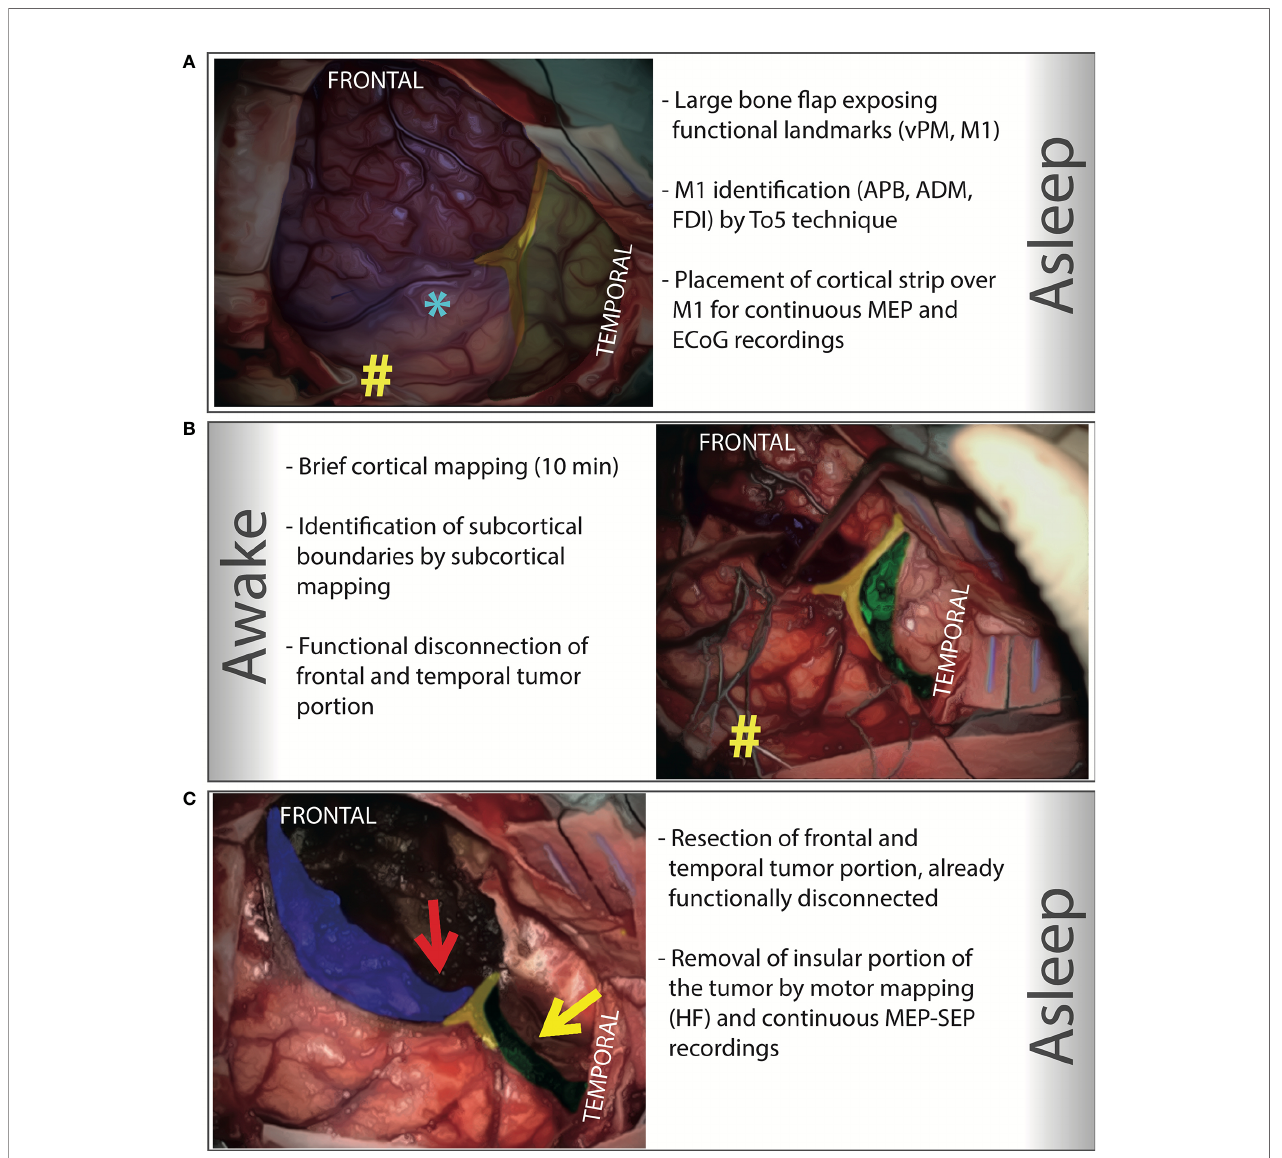
FIGURE 1 | Step-by-Step illustration of an asleep-awake-asleep transcortical approach to a right giant insular low-grade glioma. Intraoperative pictures have been colored with different inks to highlight the key elements of each step. (A) A large bone fl ap exposing the functional cortical landmark (M1 and vPM, marked with # and *, respectively) is designed and performed under general anesthesia. The motor cortex is identi fi ed (by HF stimulation, Train of Five, ISI 3, delivered by a monopolar probe), looking for hand muscle responses (APB, ADM, FDI) at cortical motor threshold (the lowest current intensity which produced the lowest MEP response); a cortical strip is placed over this area to obtain a continuous MEP monitoring; the same strip is also used to record ECoG. (in blue is colored the frontal lobe, in green the temporal lobe, and in yellow the Sylvian fi ssure). (B) The awake phase consists of a cortical and a subcortical step. In the cortical step, which last approximately 10 minutes, by cortical mapping (LF delivered by a bipolar probe) functional cortical sites are located over the frontal and the temporal lobe, and negative cortical sites identi fi ed to design the safe cortical entry zone in both frontal and the temporal lobe; the corticectomy is then performed at the posterior border of both lobes. In the subcortical step (20-30 minutes on average), with the aid of subcortical mapping, the functional limits in the frontal and temporal lobes are identi fi ed. Limits are immediately sought at the periphery, starting from the corticectomies. In this way, a functional disconnection of the frontal and temporal portion of the tumor is progressively obtained. Resection is precisely achieved according to functional limits, always identi fi ed, and representing the resection limits in the frontal and temporal lobe. Functional subcortical margins are marked and secured with patties (in the fi gure, the subcortical functional margin in the frontal lobe is marked with patties; a neuro-navigation probe is also placed inside its inferior portion; green : subcortical functional margin at temporal level; yellow : the Sylvian fi ssure; #: the tip of the cortical strip). (C) The last phase is performed under general anesthesia. The tumor frontal and temporal portions are resected according to the functional boundaries de fi ned during the awake phase. This maneuver highlights the tumor insular portion, either through the frontal ( red arrow ) or temporal ( yellow arrow ) window. Afterwards, the insular portion of the tumor is removed with the aid of HF motor mapping and continuous MEP-SEP monitoring. (In blue highlighted the subcortical functional margin at frontal level; in green the subcortical functional margin at temporal level; in yellow the Sylvian fi